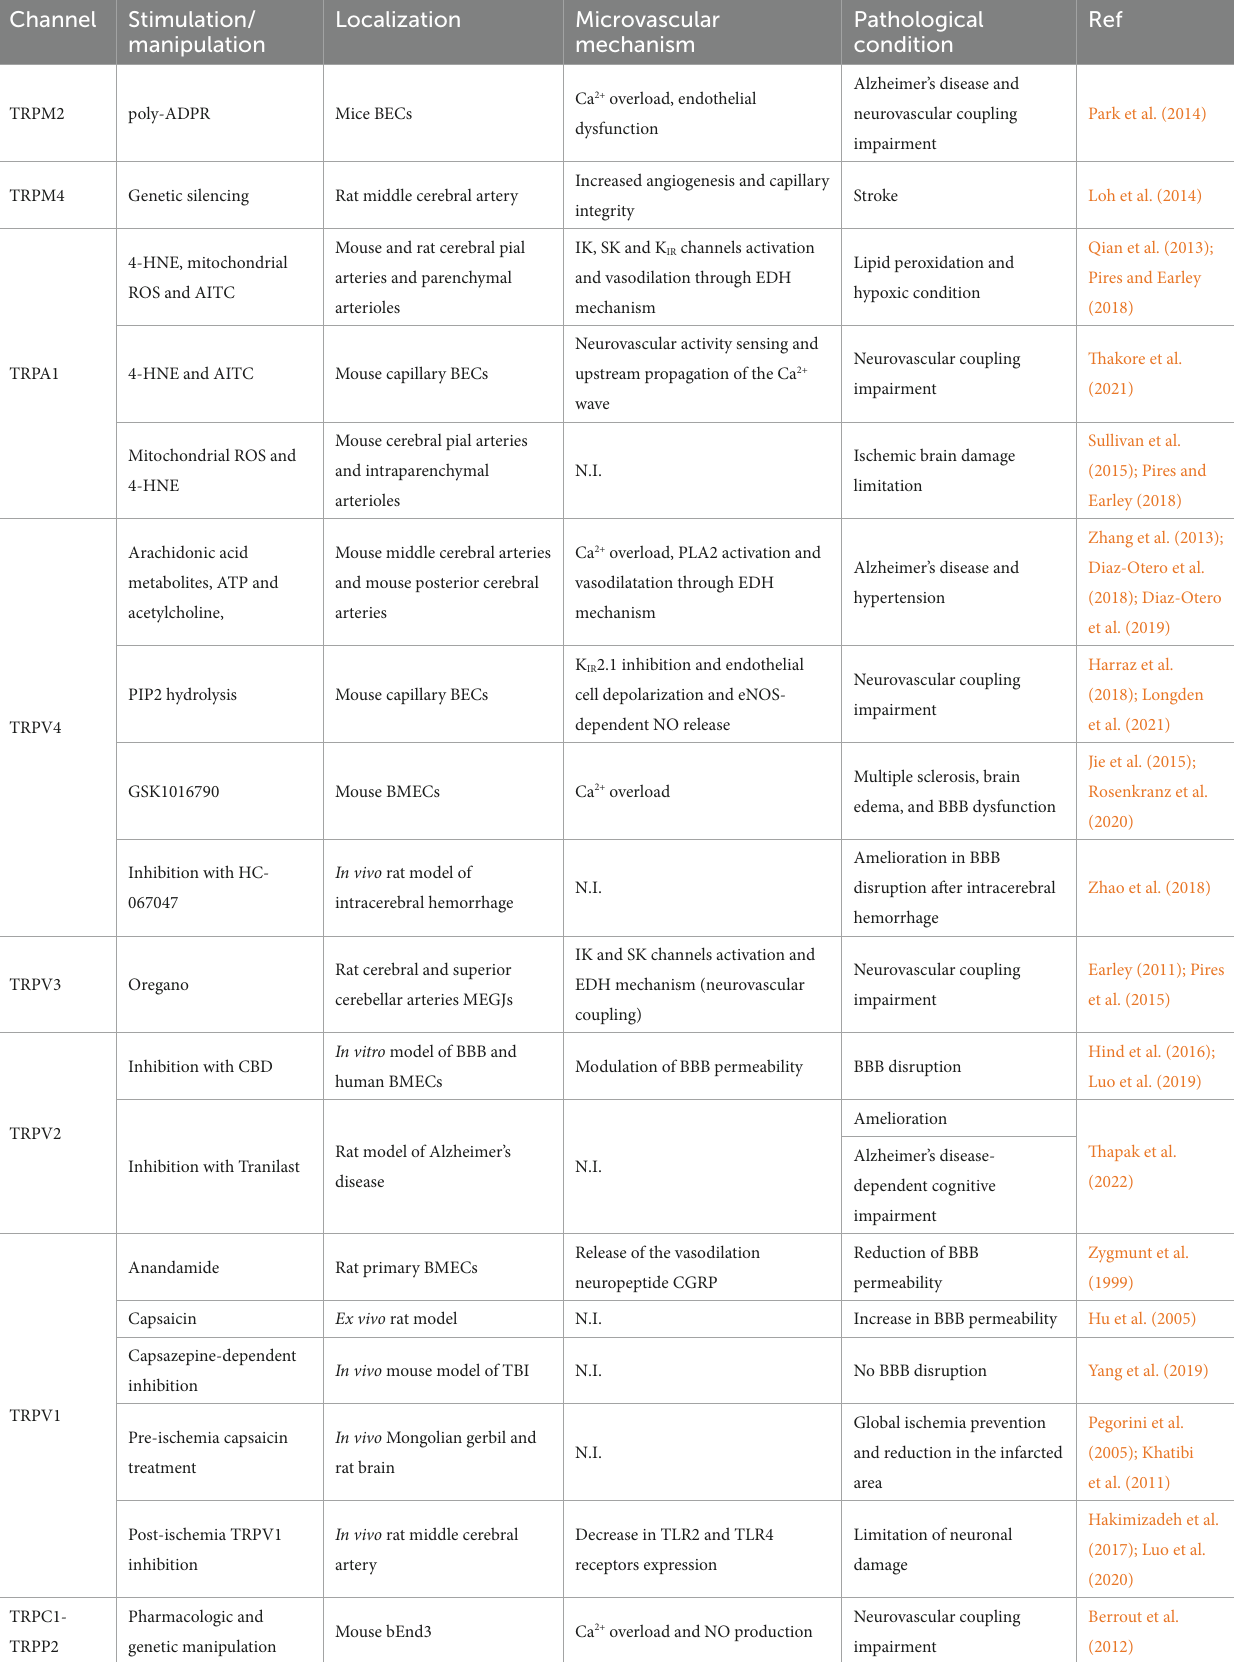
TABLE 1 Endothelial transient receptor potential (TRP) channels involved in cerebrovascular functions.